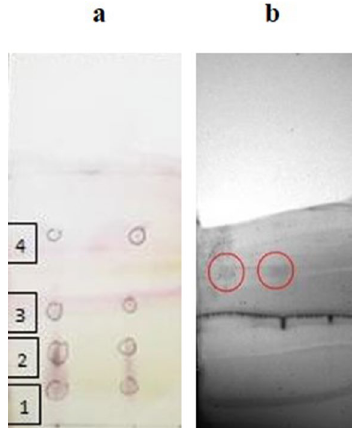
Figure 1. Thin layer chromatography (TLC) result of the M. carbonarius defense fluid extract shows four different compounds in plate a and the standard band (red circle) in plate b .